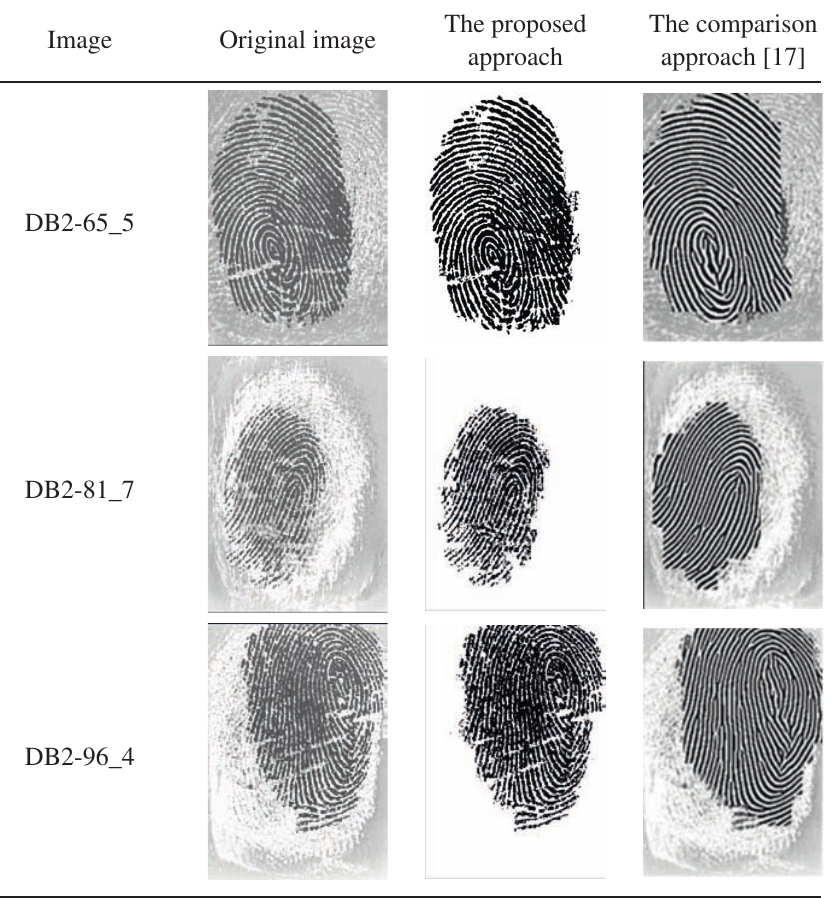
Table 5. Segmentation comparison of the proposed approach with the one proposed by Yin et al.